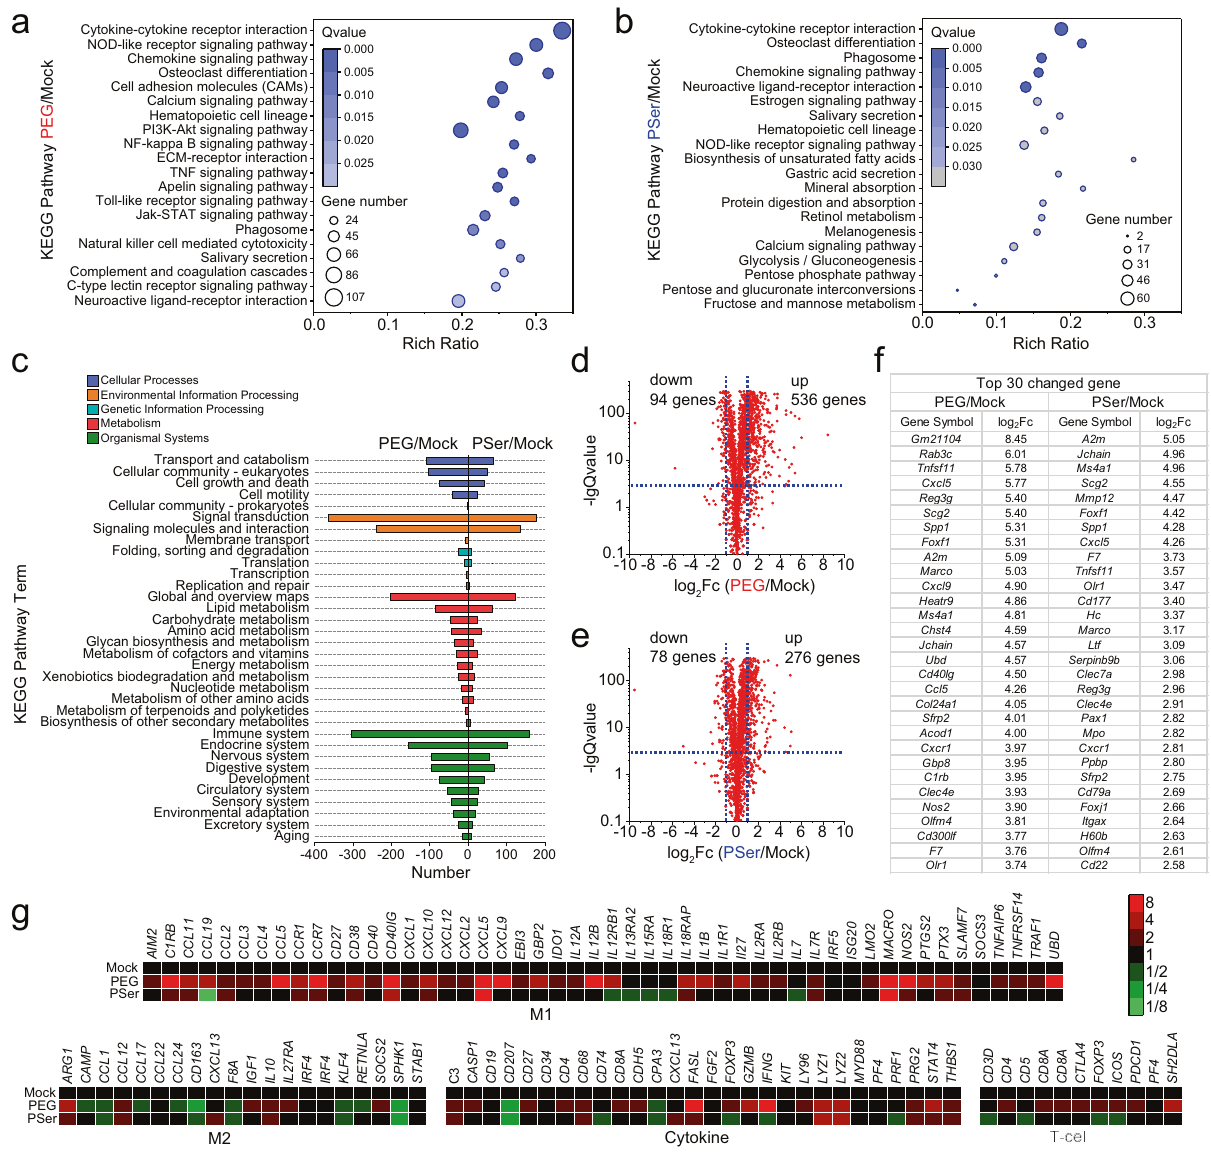
Fig. 6 RNA-seq 2 weeks post implantation. a , b KEGG pathway enrichment analysis of PEG/Mock comparison ( a ) and PSer/Mock comparison ( b ). c KEGG pathway classi fi cation analysis of PEG/Mock comparison and PSer/Mock comparison. d , e , f Signi fi cant gene expression changes of PEG/Mock comparison ( d ) and PSer/Mock comparison ( e ) in genes involved in the immune system as measured by GO classi fi cation analysis, and a list of top 30 upregulated genes and corresponding log 2 Fc (log 2 fold change) ( f ). g Gene expression analysis of in fl ammatory factors in tissues surrounding the PEG and PSer hydrogels, with data normalized to the mock group (without implantation). n = 3 mice per